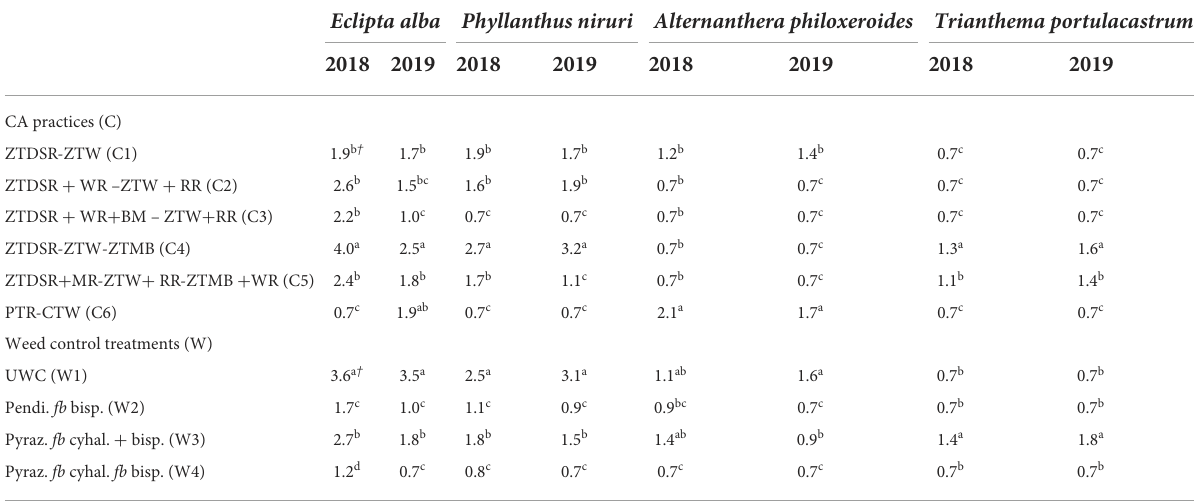
TABLE 5 Species-wise broad-leaved weeds density (no. m − 2 ) in rice as influenced by CA and weed control treatments at 60 DAS/DAT during 2018 and 2019. Treatment